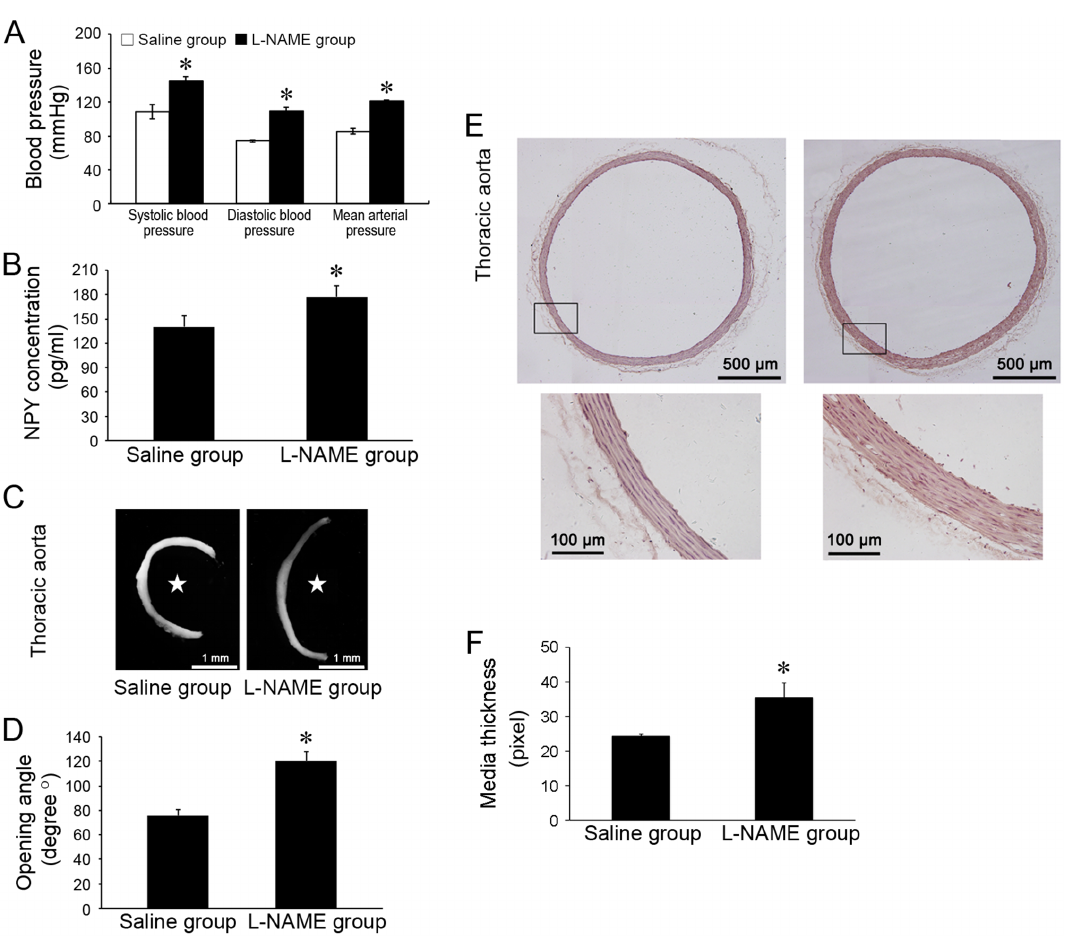
Fig 1. The changes of blood pressure, plasma NPY concentration, and opening angle of thoracic aorta in the gestational hypertensive rat model. (A) The systolic blood pressure, diastolic blood pressure and mean arterial pressure were significantly increased in L-NAME group compared with saline control group ( n = 4). (B) The plasma concentrations of NPY in L-NAME group was higher than saline control group ( n = 4). (C) Representative microscopic images illustrate opening angles. Star-marked the inner wall of arteries. (D) The opening angle of aorta in L-NAME group was significantly increased compared with that in saline control group ( n = 4, and for each n there were 4 rings). (E) Representative microscopic images of H&E staining illustrate media thickness. (F) The thickness of aortic media in L-NAME group was significantly increased compared with that in saline control group (saline control group, n = 4. L-NAME group, n = 5, and for each n there were 4 microscopic images). Shown values are the mean ± SD , * P < 0.05 v . s . the saline control.